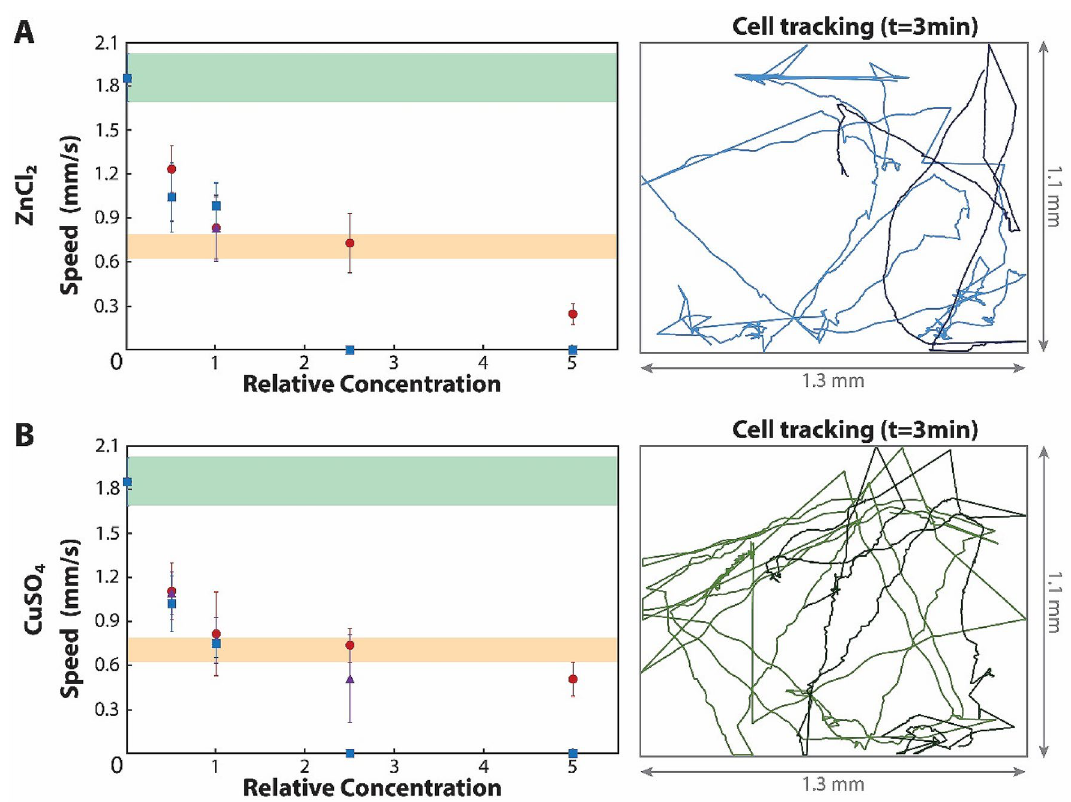
Figure 2. Paramecia in the presence of heavy metals. ( A ) Swimming speed of paramecia in different concentrations of zinc chloride (left). Red circular markers represent the speed immediately after the Paramecia are mixed in the Zinc chloride contaminated sample. Purple triangles and blue squares represent the average swimming speed of Paramecia after 24 and 48 h, respectively. Concentrations are relative to the PL (5 mg/l). The green and orange areas are the average and range of Paramecia speeds in unpolluted (green) and polluted (orange) media. The image on the right side is two characteristic paths followed by the Paramecia for 3 min at PL (light blue) and at five times PL (dark blue). Both are taken immediately after the Paramecia were mixed in the contaminated samples, and it represents the whole field of view. ( B ) Same representation than ( A ) but for copper sulfate. Markers use the same color code. PL, in that case, is 2 mg/l. The paths at the right side are for PL (light green) and five times PL (dark green). Error bars represent standard deviation of the average swimming speeds. Statistical significances are analyzed in Supplementary Fig. 2 and cumulative distances in Supplementary Fig.